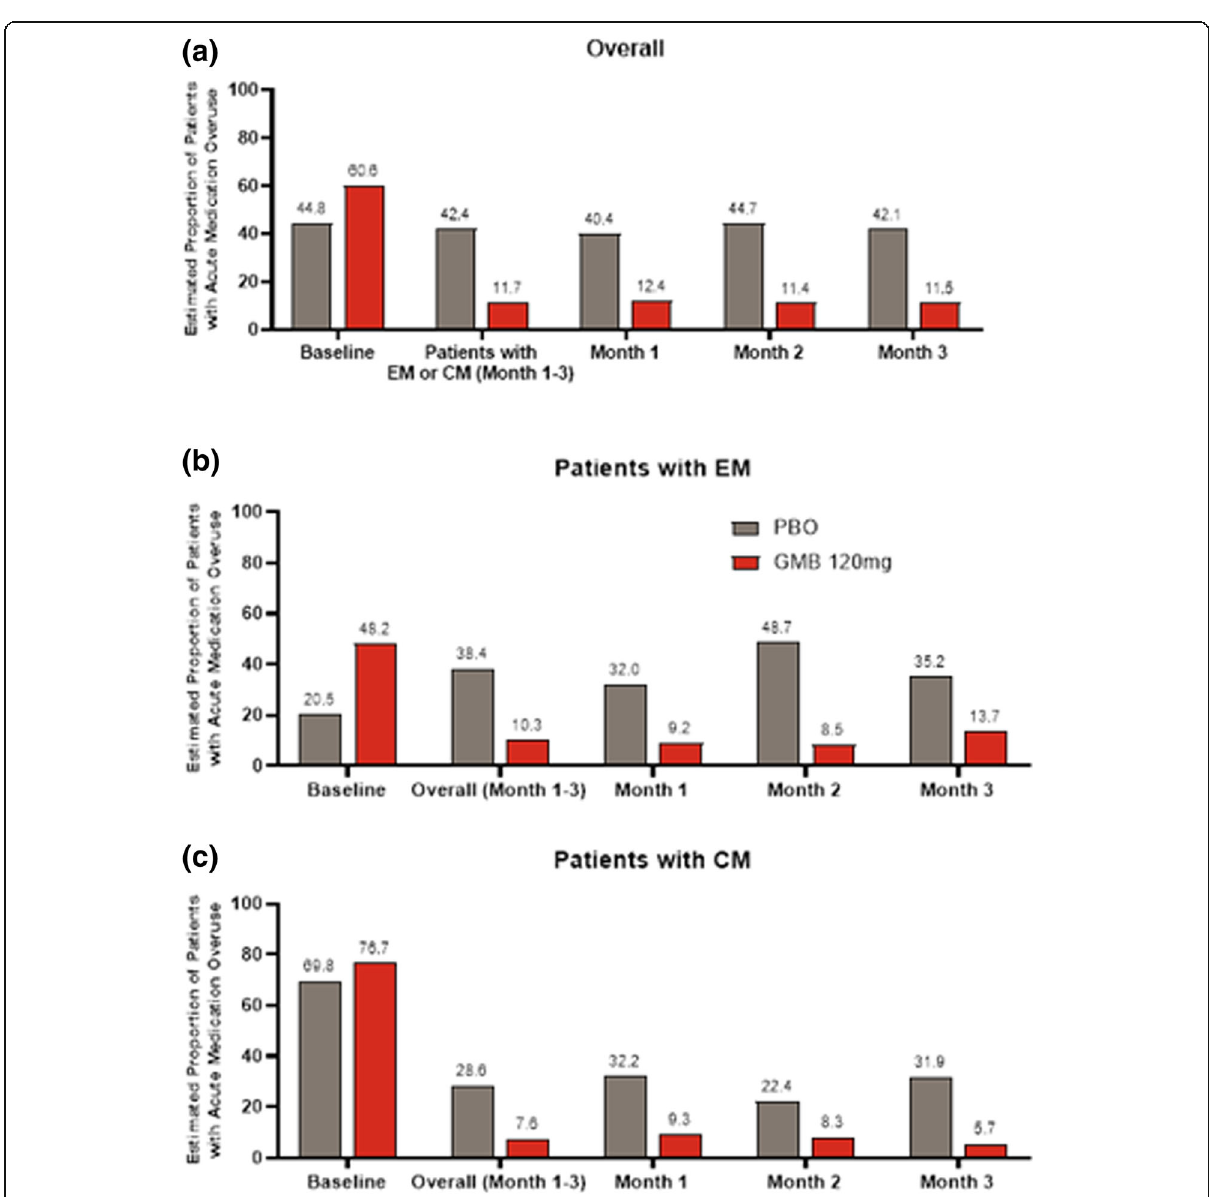
Fig. 3 Estimated proportion of patients with acute medication overuse: a . Overall, b patients with episodic migraine and c patients with chronic migraine. Abbreviations: CM, chronic migraine; EM, episodic migraine; GMB, galcanezumab; PBO,